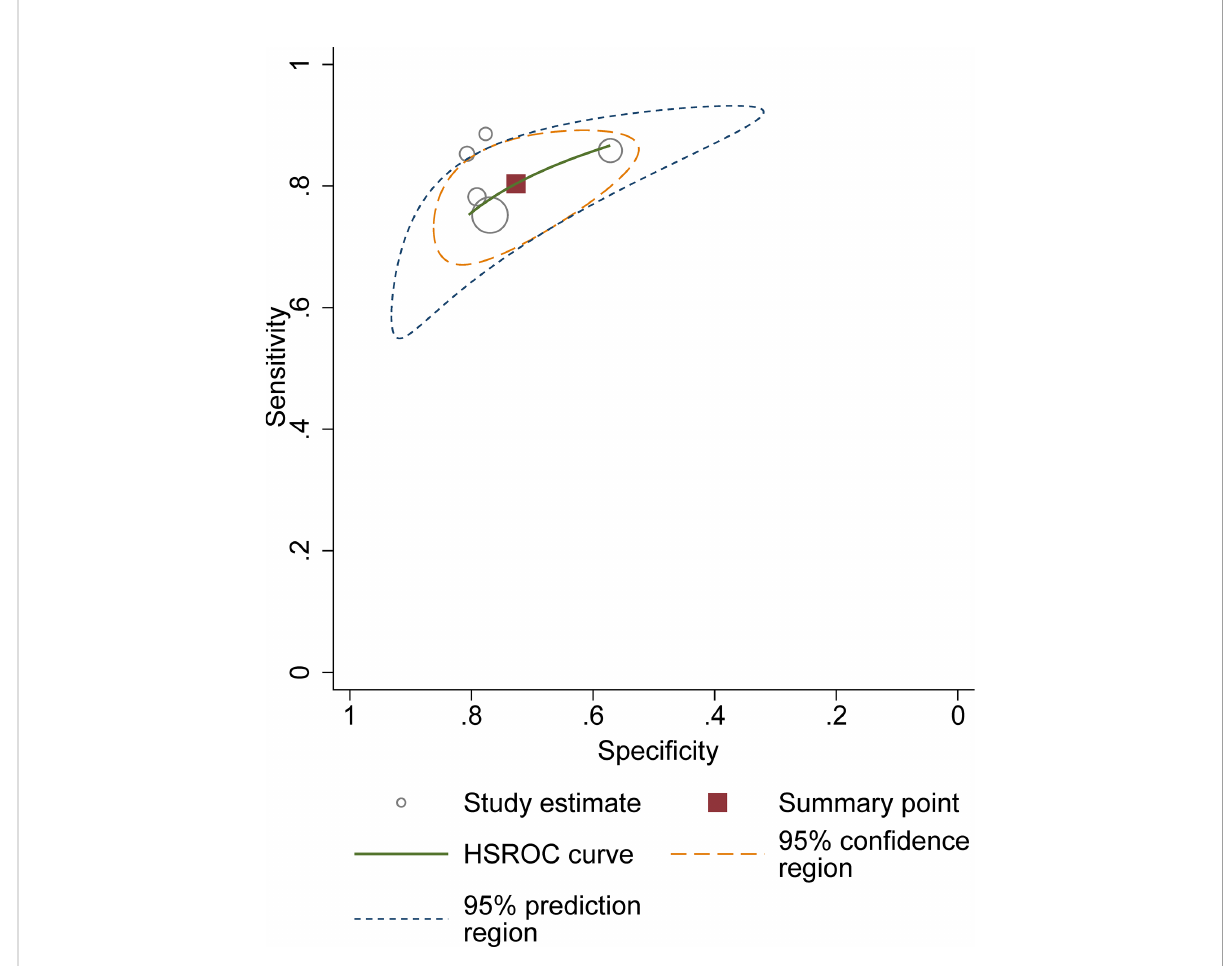
FIGURE 5 Hierarchic summary receiver operating characteristic plots with summary point and 95% con fi dence area for the